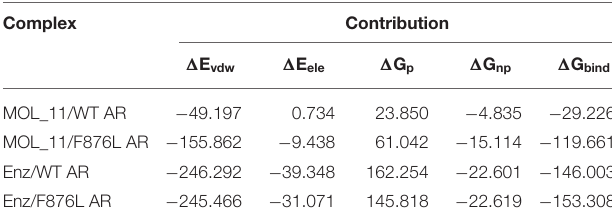
TABLE 3 | Enz/F876L AR, MOL_11/WT AR, MOL_11/F876L AR, Enz/WT AR system combined with free energy analysis (unit: kcal • mol − 1 ).